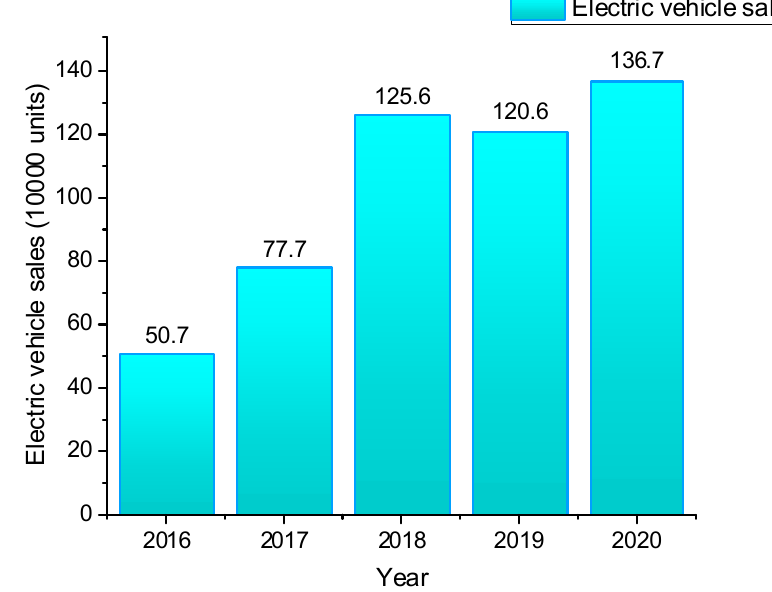
Figure 2. Sales of electric vehicles in China from 2016 to 2020.